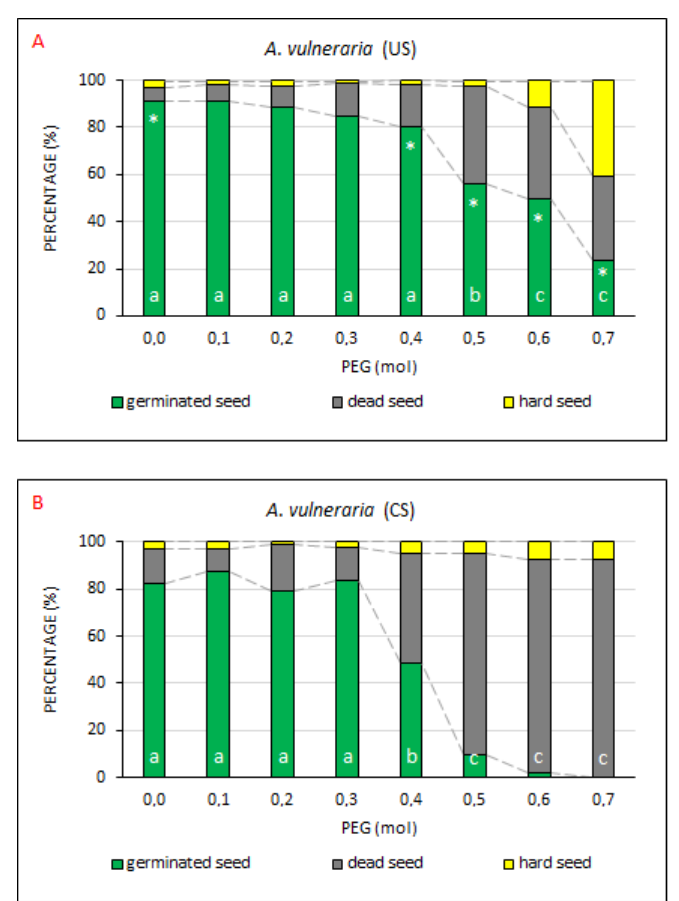
Figure 6. The comparisons of germinated, dead and hard seed percentages at drought simulation degrees. Average percentages of GS, DS and HS for A. vulneraria , the US (uncoated seeds – A ; n = 4 ± SE) and CS (coated seeds – B ; n = 4 ± SE) treatments at the respective PEG concentrations = 0.0 – 0.7 mol. Different lowercase letters indicate a significant difference (ANOVA post-hoc Tukey´s HSD test; p < 0.05) between the percentage of GS in the US and CS treatments. The * symbol represents a significant difference in the percentages of GS between US and CS at a specific PEG concentration.